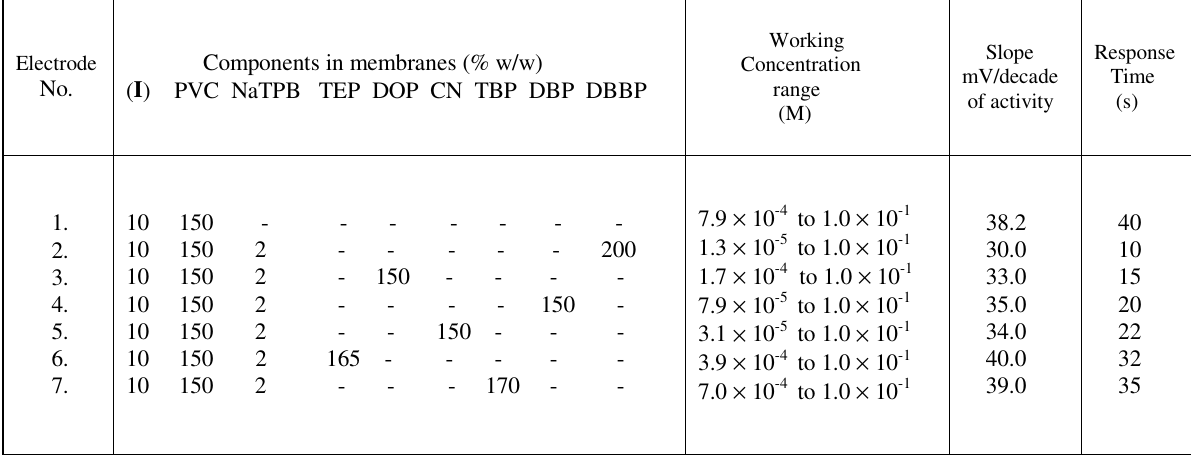
Table 1: Composition and response characteristics of Zn 2+ - selective electrode